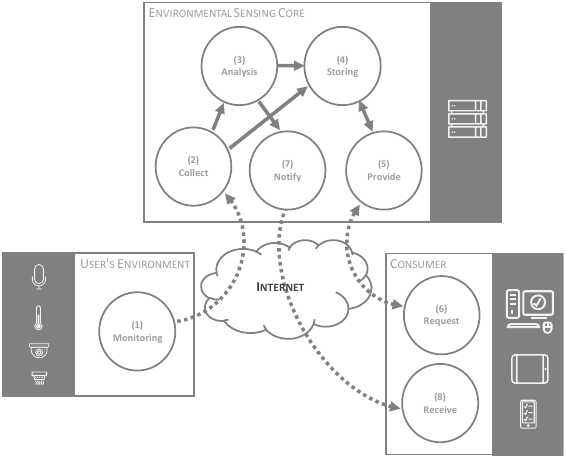
Figure 1. Proposed model.